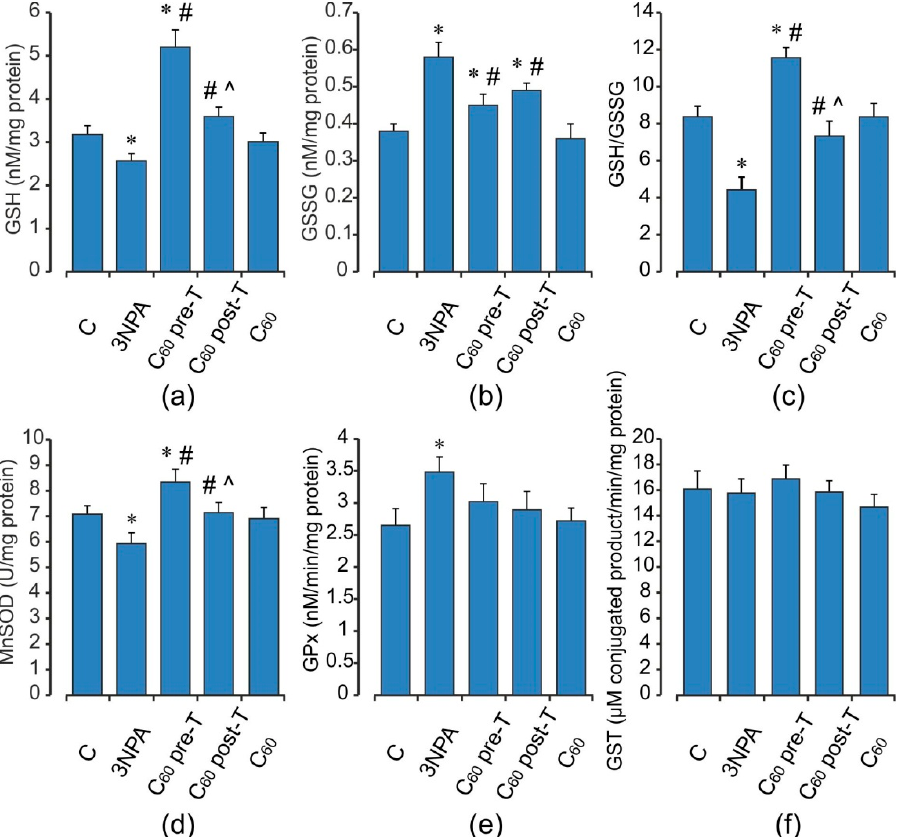
Figure 3. Effect of 3-NPA and C 60 administration on glutathione pool ( a – c ) MnSOD ( d ), GPx ( e ), and GST ( f ) activities in brain mitochondria. Values are means ± SD (replicates = 8). The data were analyzed for statistical significance using ANOVA followed by the Bonferroni post hoc test. (C)—control; (3NPA)—3-nitropropionic acid treated rats; (C 60 pre-T)—C 60 administration in pre-treatment regimen; (C 60 post-T)—C 60 administration in post-treatment regimen; (C 60 )—C 60 administration alone. * p < 0.05 vs. control group; # p < 0.05 vs. 3-NPA treated rats; ^ p < 0.05 vs. C 60 pre-T group.